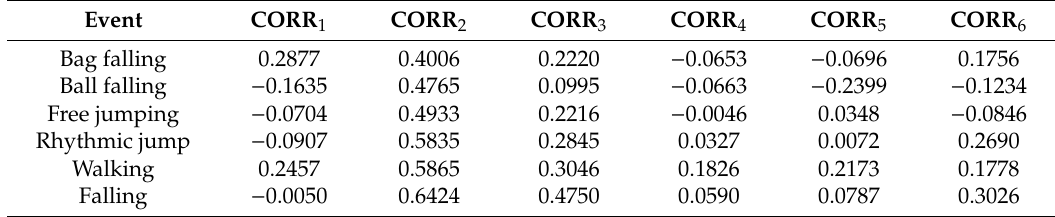
Table 4. Typical eigenvector at excitation position 1 of sensor correlation coe ffi cient feature set.